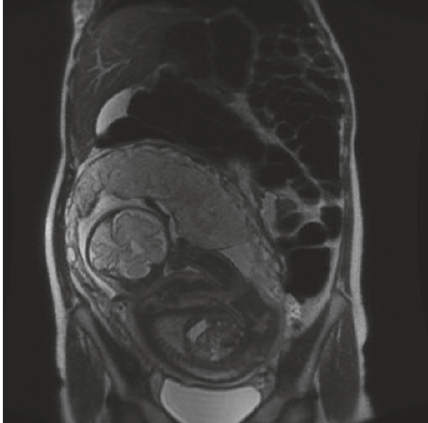
Figure 1: Magnetic resonance imaging without contrast performed at 32 weeks’ gestation. There is marked distention of the sigmoid colon beginning at the level of the sigmoid along the left lateral aspect of the uterus where there appears to be a small, early (90 degree) twist of the sigmoid colon. The fetus may also be seen in this image.